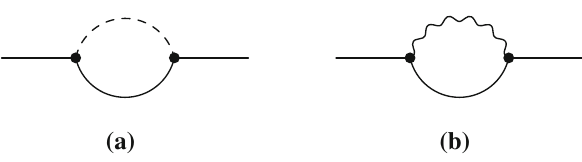
Fig. 12 Generic one-loop diagrams for the fermion